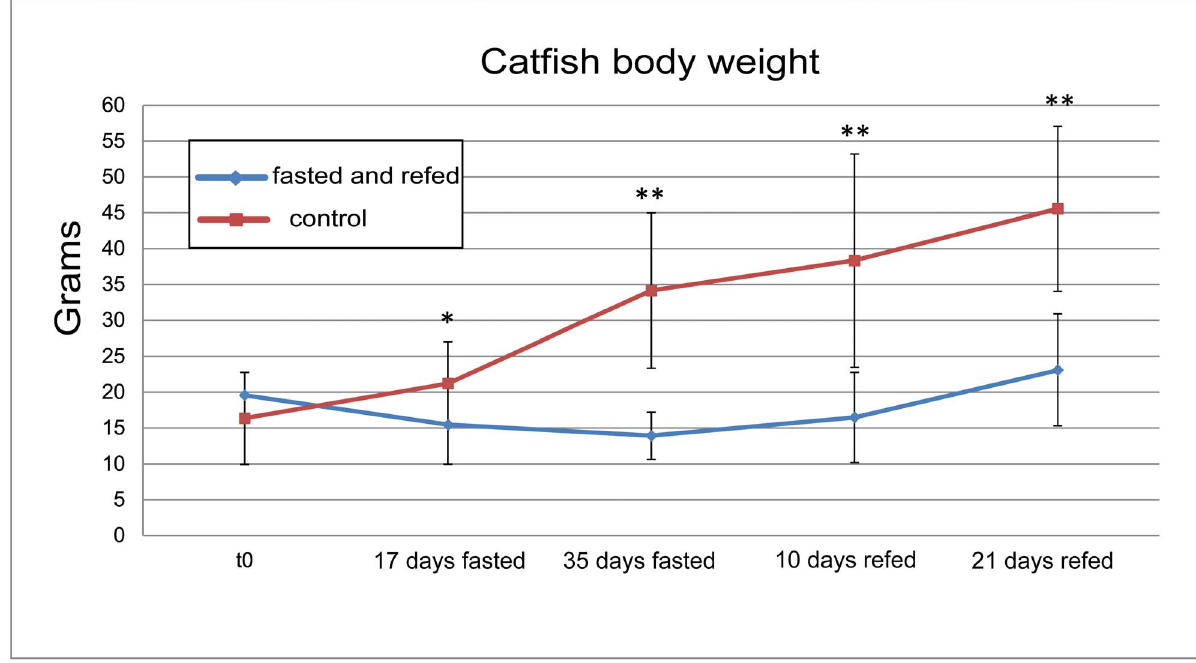
Figure 1. Fish body weight during the experiment. The means of fifteen animals at each time point are shown. Bars indicate standard deviation. Differences were determined by Student’s t-test. Asterisks indicate significantly different means between ‘‘control’’ and ‘‘fasted and refed’’ within each time point (*P , 0.05; **P , 0.01).